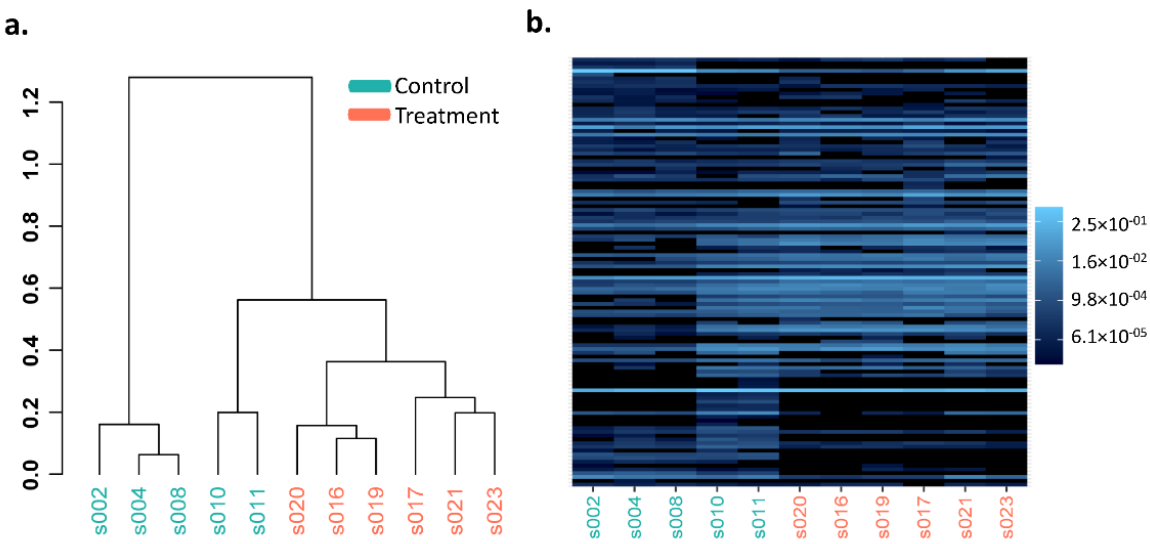
Figure 4. Genus level Bray–Curtis dissimilarity comparisons in the GI microbiota dysbiosis (treat- ment) ( n = 6) and control ( n = 5) groups. ( a ) Hierarchical clustering, ( b ) heatmap.